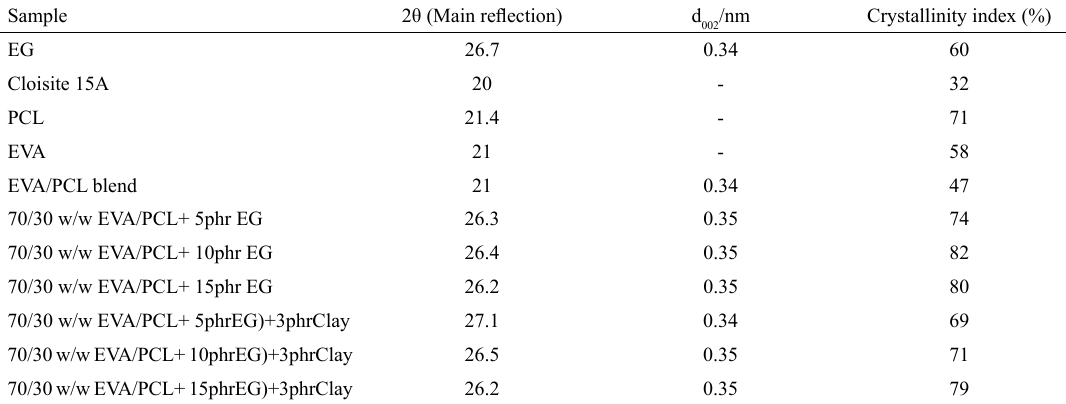
Table 1: Crystallinity index and Basal spacings of the EG in the samples. Sample